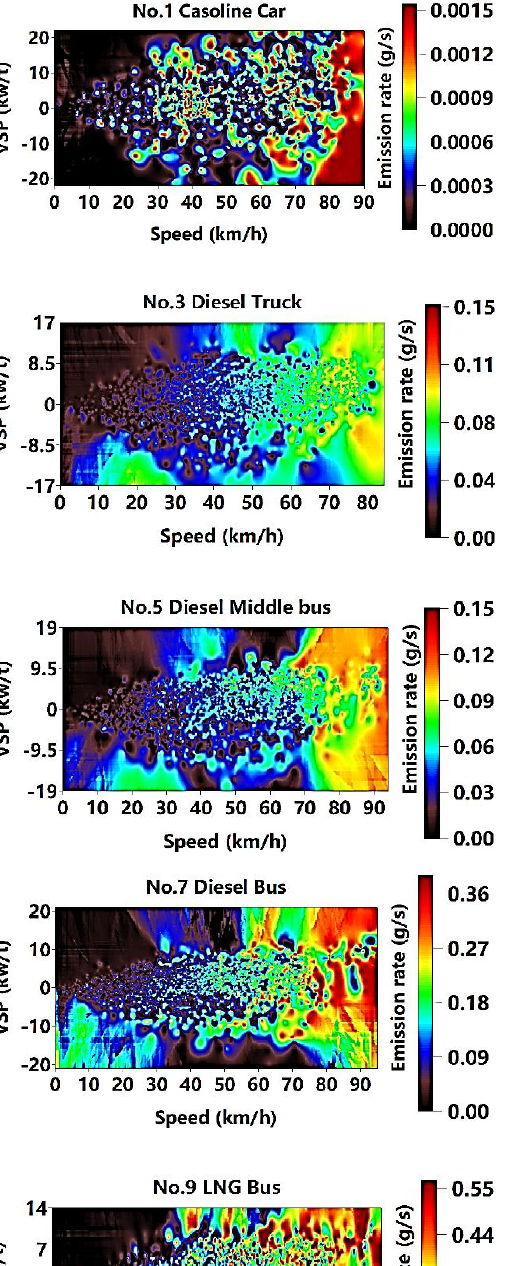
Figure 5. The image maps of the relationship between speed-VSP and PN emission rates. PN emission rates are represented by the colors. The black, brown, blue, cyan, green, yellow, orange, red, and ruby